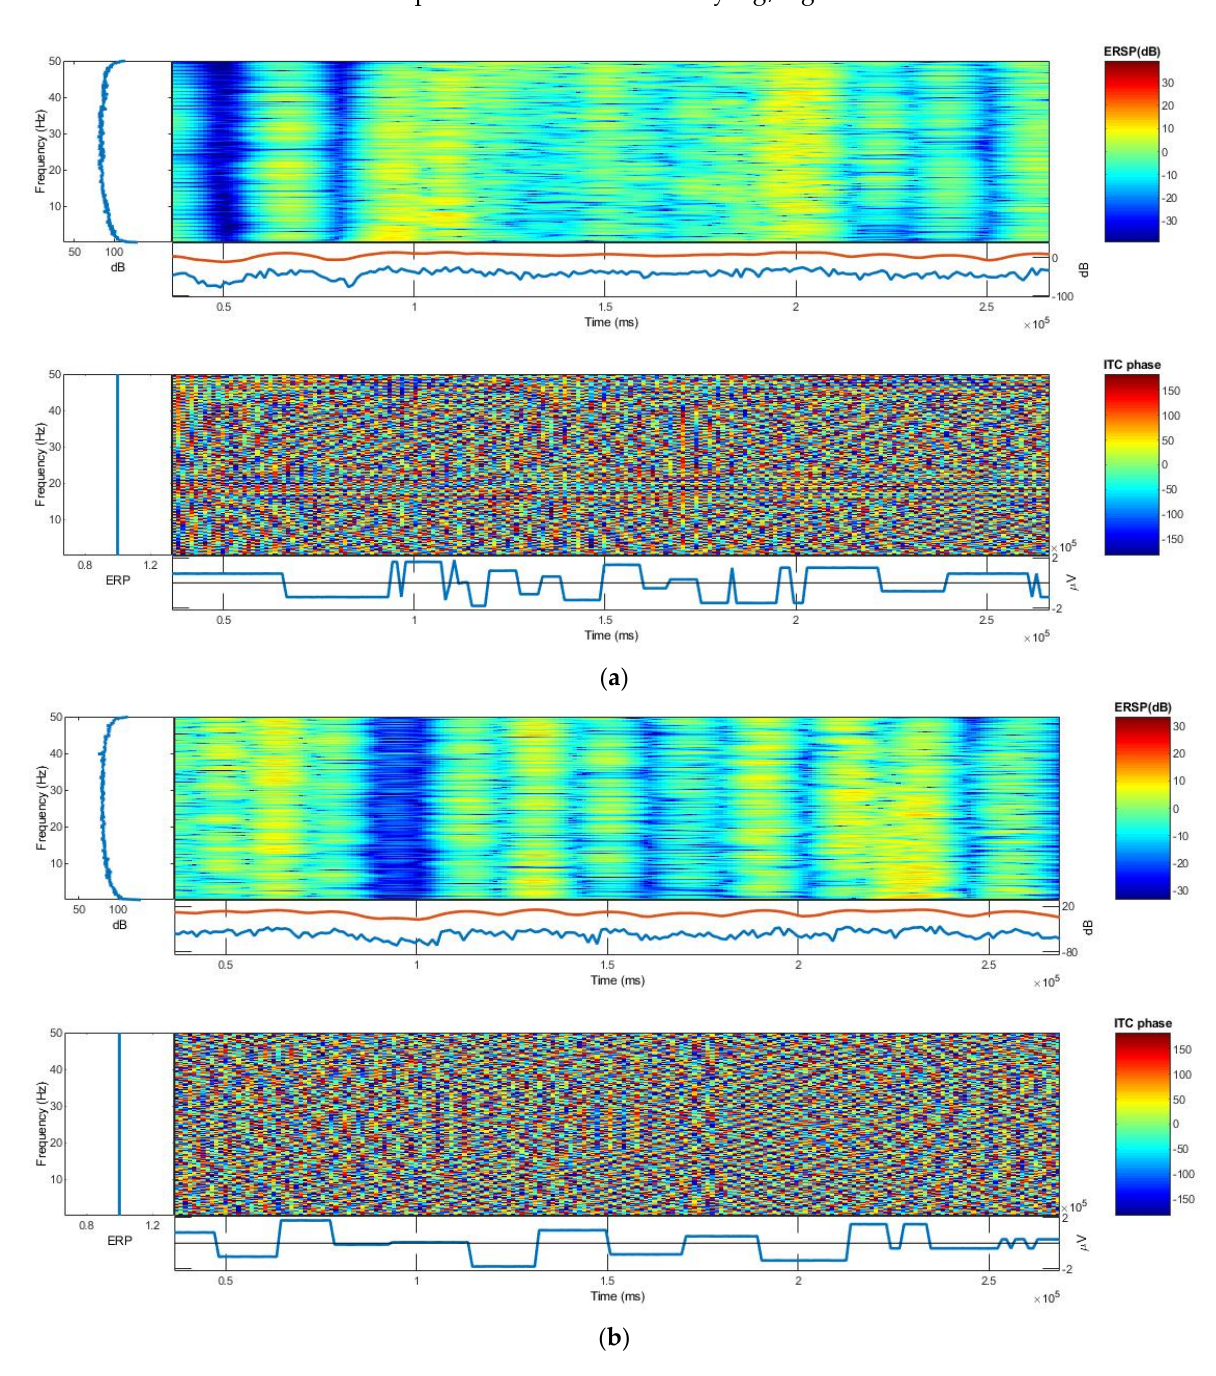
Figure 14. The event-related spectral perturbation (ERSP) and intertrial coherence (ITC) plots: ( a ) textile electrode and ( b ) dry Ag/AgCl electrode.